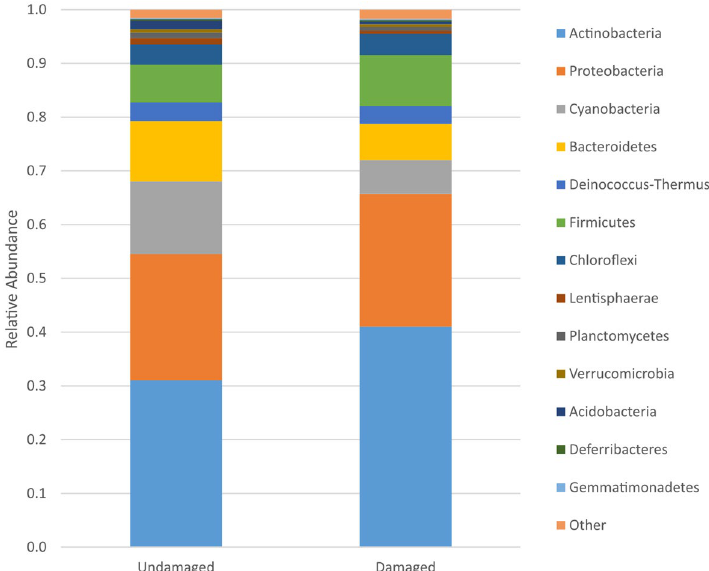
Figure 1. Phylum level taxonomy of damaged and undamaged stone communities based on the average 16S amplicon datasets of each community. While the 13 phyla shown compose more than 98% of these stone microbial communities the samples were clearly dominated by Actinobacteria, Proteobacteria and Cyanobacteria on both